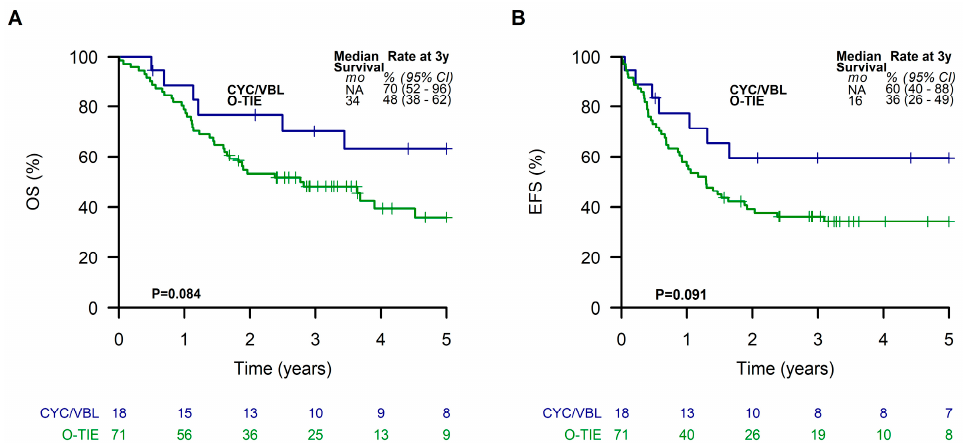
Figure 4. Overall survival ( A ) and event-free survival ( B ) of patients receiving the two different metronomic long-term maintenance therapies.